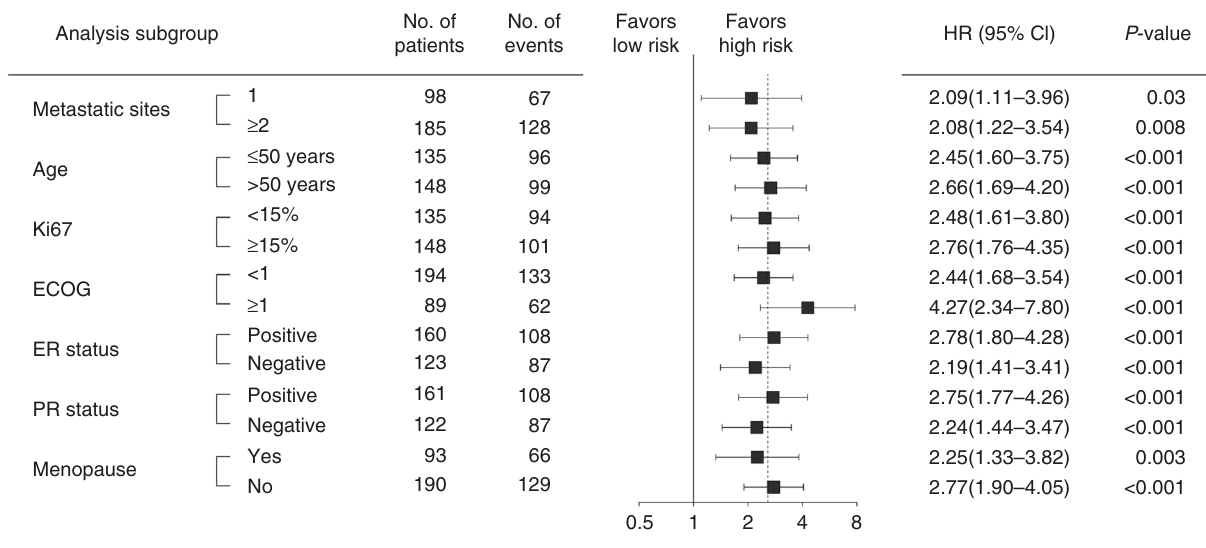
cohorts . Univariate analysis of the four single miRNA showed that each miRNA was independent prognostic factors in HER2 MBC patients with trastuzumab treatment (Table 2). Further- more, univariate and multivariate survival analysis were per- formed on the 4-miRNA signature and clinicopathological features for OS and PFS. Both the 4-miRNA signature and the